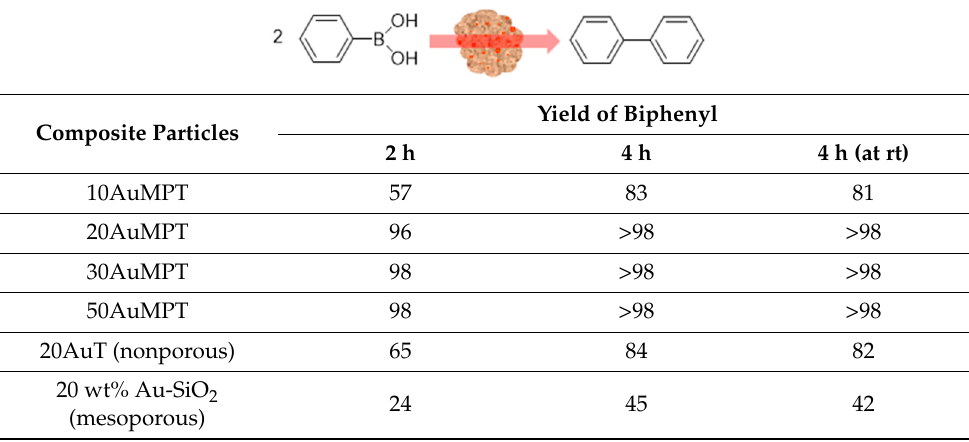
Table 2. Homocoupling reaction of phenylboronic acid using the composite particles.